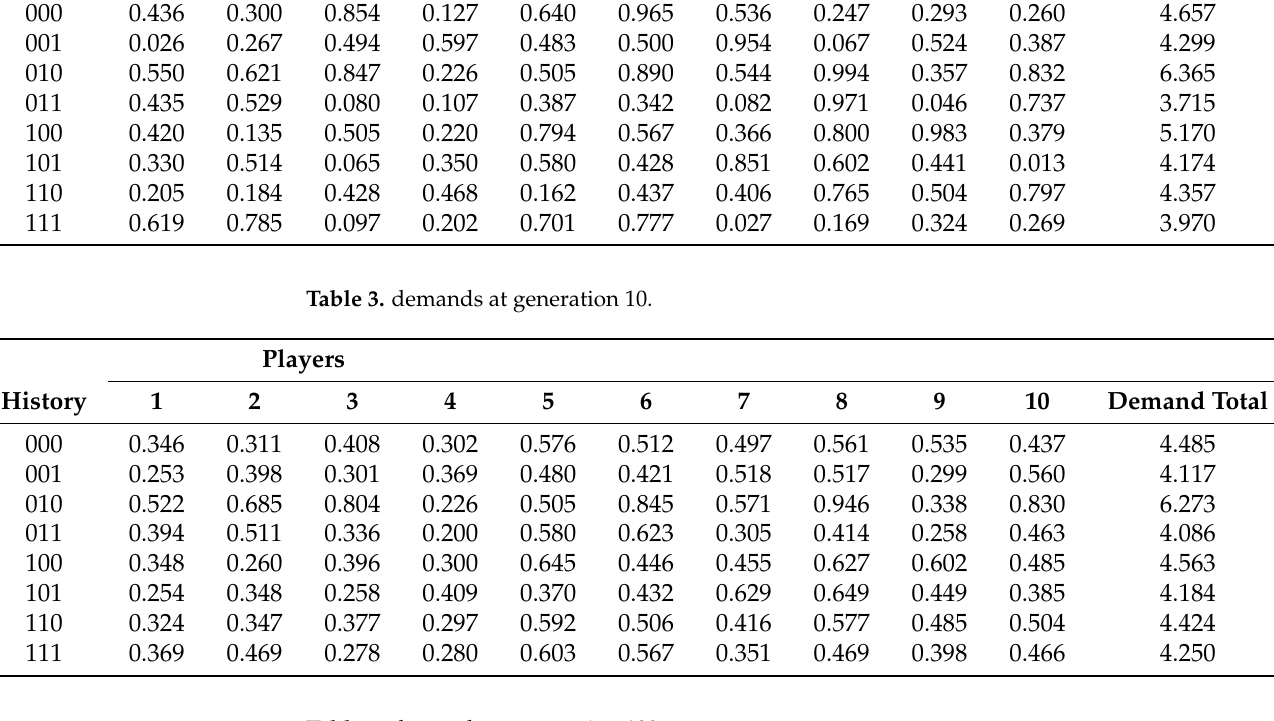
Table 4. demands at generation 100.